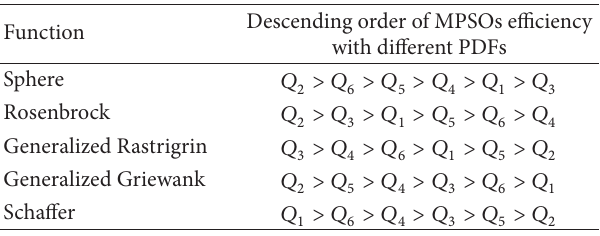
Table 7: Descending order of MPSOs efficiency with different PDFs for testing benchmark